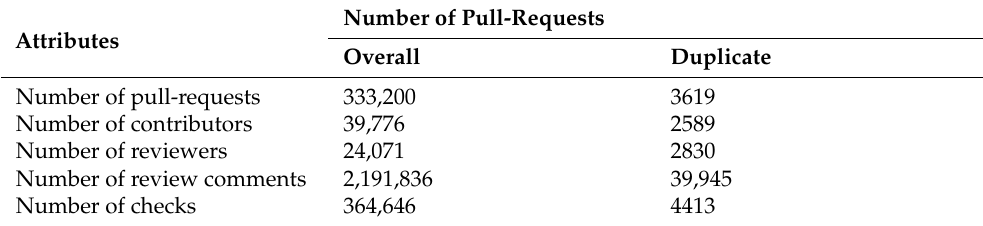
Table 2. Dataset description of DupPR-basic data.